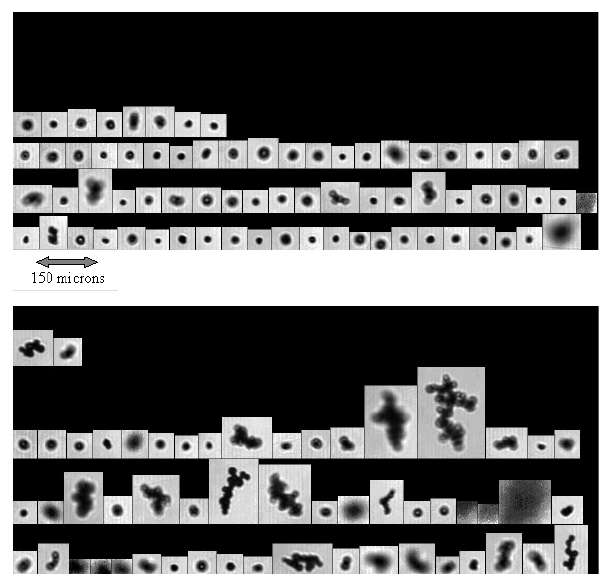
Figure 8. Examples of CPI images on the edges of the anvil (22:46:12 to 22:46:14 top) and in the region of the peak in NO x (22:47:04 to 22:47:06, bottom), corresponding to the data presented in Fig. 7.